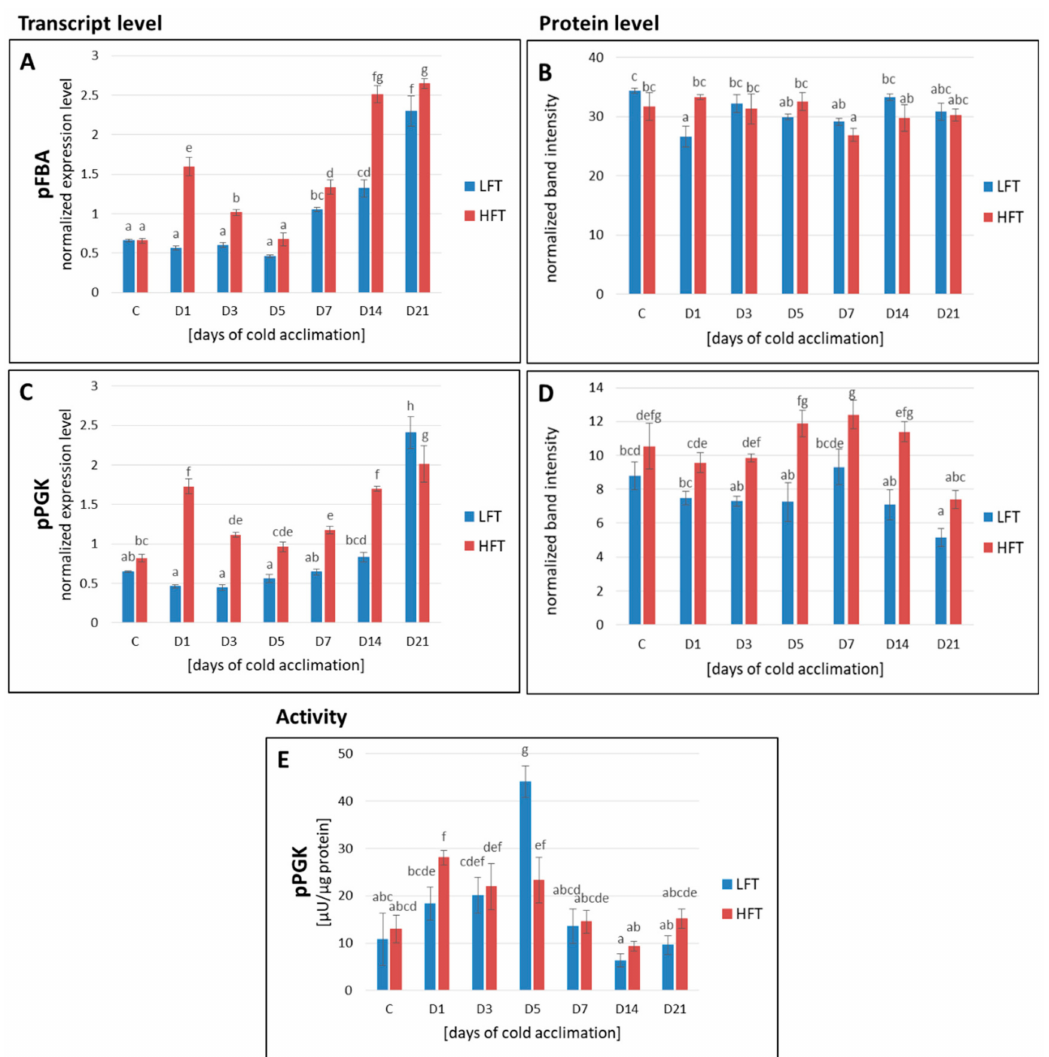
Figure 4. Transcript ( A , C ) and protein ( B , D ) accumulation levels of plastid fructose-1,6-bisphosphate aldolase (pFBA; ( A , B )), and plastid phosphoglycerate kinase (pPGK; ( C , D )), as well as the activity of pPGK ( E ), at seven time-points: before cold acclimation (CA) C and on the 1st, 3rd, 5th, 7th, 14th, and 21st day of CA in Lolium multiflorum / Festuca arundinacea introgression forms. Error bars represent the standard errors of three replicates for protein analyses, and four replicates for transcript analyses. Homogeneity groups are denoted by the same letters, according to Fisher’s LSD test ( p = 0.05). HFT–high freezing tolerant introgression form, LFT–low freezing tolerant introgression